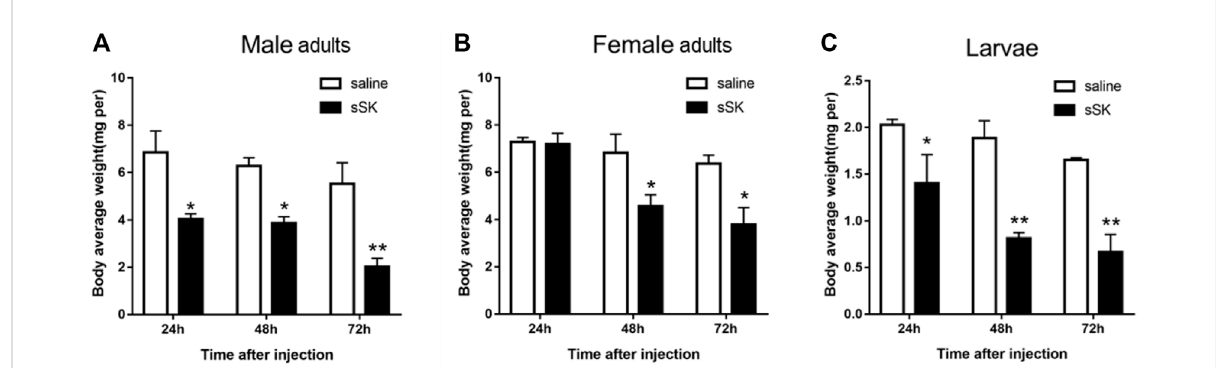
FIGURE 8 Effect ofsSKpeptideon bodyaverageweight ofmale adults (A) ,femaleadults (B) ,and larvae (C) .Sampleswerecollectedandassayed at24,48, and 72 hafter injection. The asterisk indicates a signi fi cant difference betweentreatments (* p < 0.05 and ** p < 0.01, one-way ANOVA). All values are mean ± SE , n =